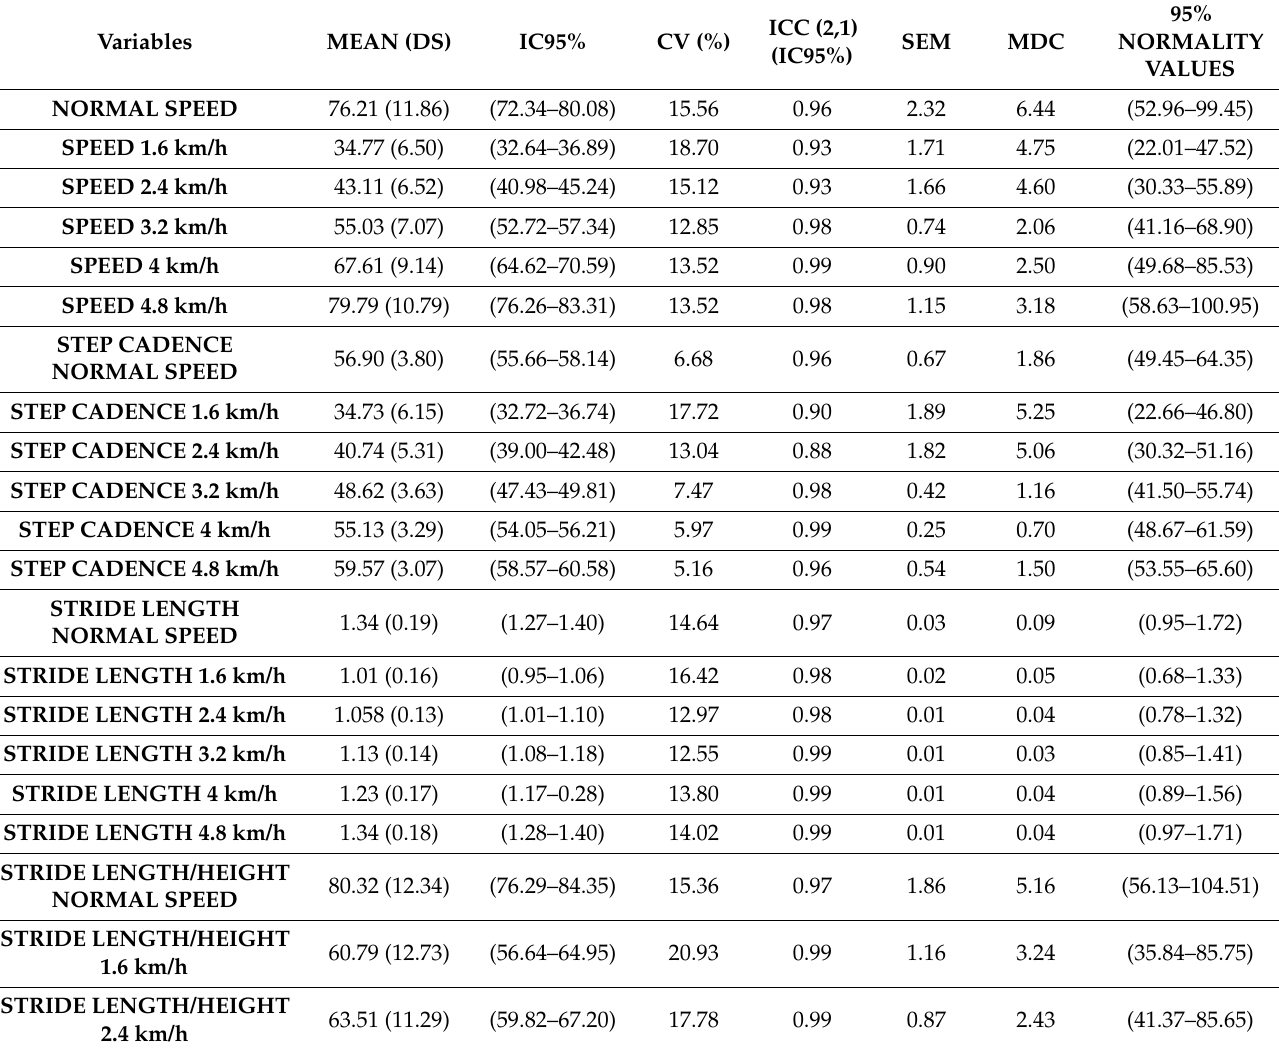
Table 3. Reliability analysis within the variables studied for the second